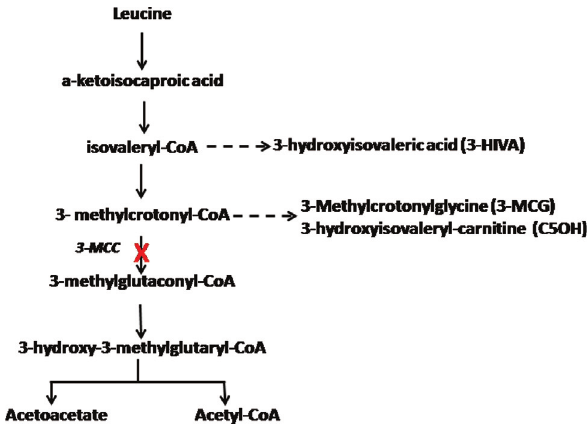
Figure 1 - The 3-MCC-catalyzed reaction and its position in the leucine catabolic pathway. The dashed arrow indicates the metabolites that accu- mulate due to deficiency of